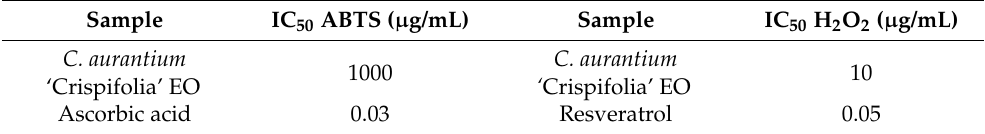
Figure 5. Determination of antioxidant activity of C. aurantium ‘Crispifolia’ EO. Panel ( A ) shows the abatement of ABTS radical activity reported as % of ABTS removed with respect to the control. Panel ( B ) shows the hydrogen peroxide scavenging activity reported as % of H 2 O 2 removed relative to the control. Data were presented as mean and standard error and they were analyzed with a paired t -test. Bars not accompanied by the same letter were significantly different at p < 0.05. Table 3. Concentration at 50% scavenging activity.